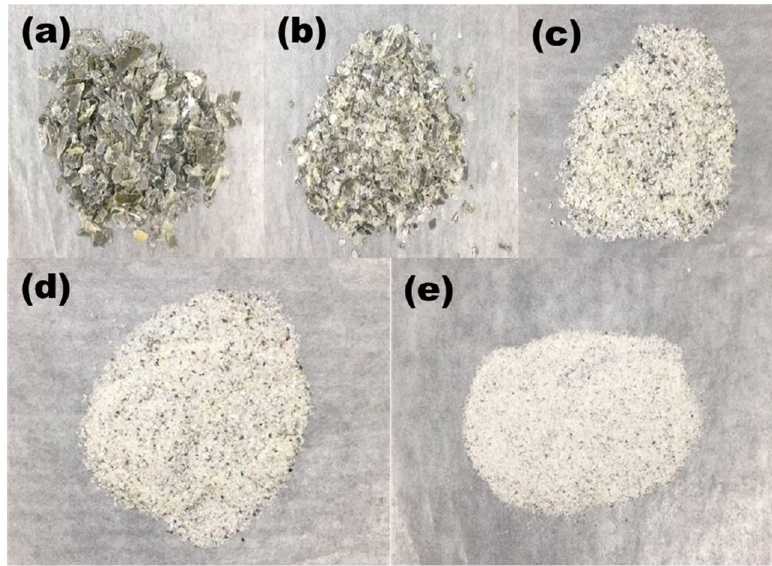
Figure 7. Photos of glass particles after sieving via ( a ) 12 ASTM E11; ( b ) 18 ASTM E11; ( c ) 30 ASTM E11; ( d ) 50 ASTM E11 and ( e ) 70 ASTM E11 sieves.